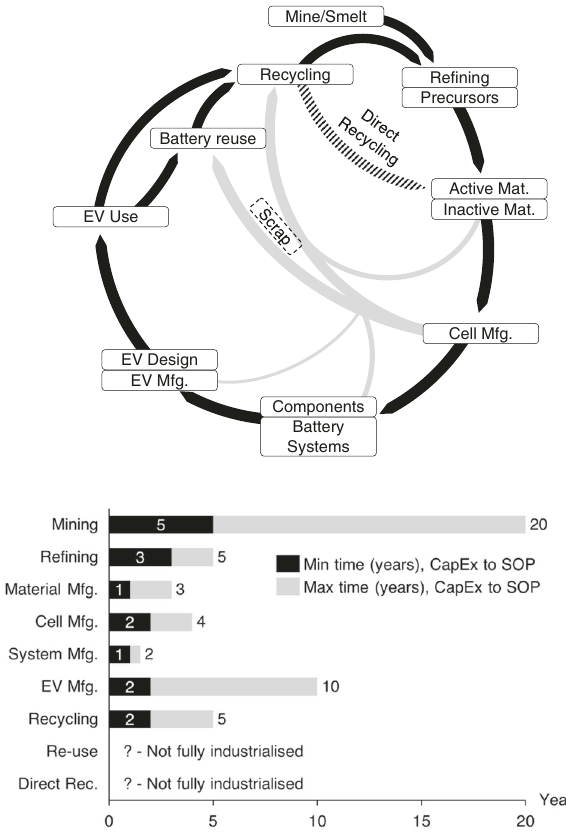
Fig. 7 | Circular EV battery value chain from mineral extraction to recycling (top), and typical time required to reach SOP (bottom). The time in years from CapExtoSOPisestimatedfromcapitalexpendituretostartaproject/planttowhen production starts. We estimate both the typical minimum time (black bar), and maximumtime(lightgrey).Weassumetechnicalmaturityandfurtherdelayscanbe expected if the technology is not developed or there is a lack of know-how. Most steps require high-precision manufacturing and can have different degrees of complexity for market entry. The values are indicative, sourced from public announcements, and in-line with those disclosed by public organizations such as EITInnoEnnergy 199 .Forscrap,weassumethatthelargestvolumewillinitiallycome from giga-factory